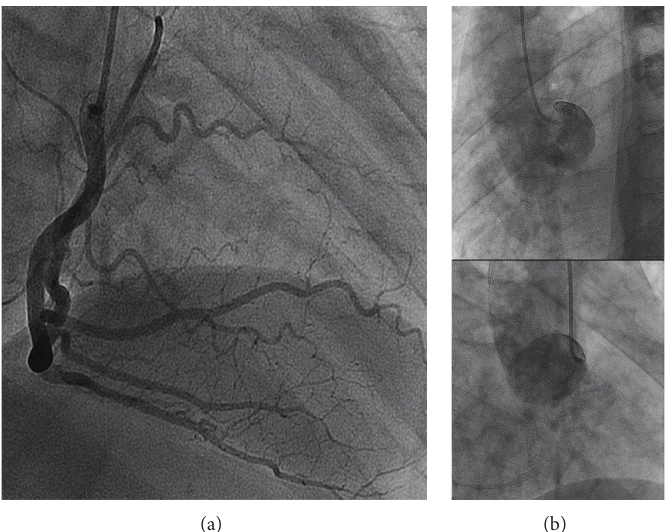
Figure 2: (a) The superdominant RCA in right anterior oblique view. (b) Nonselective injections of contrast media into the left coronary sinus showing no emergent